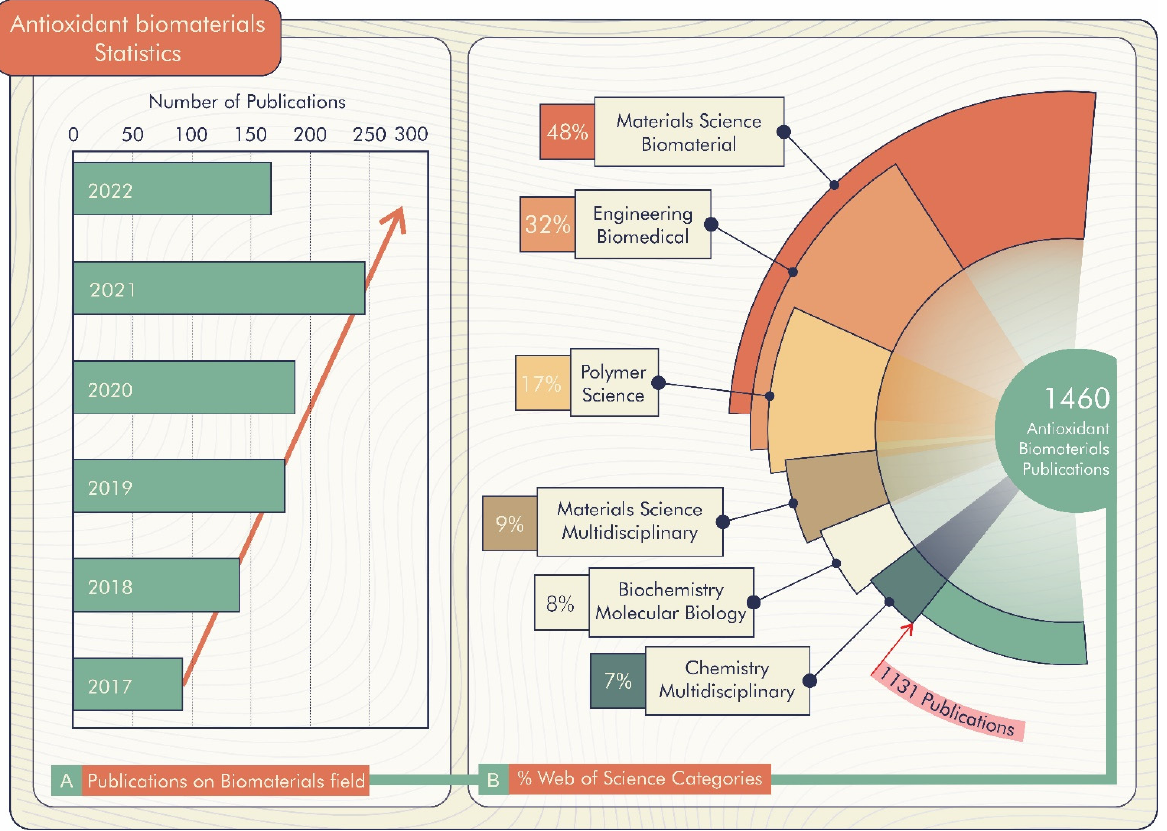
Figure 2. ( A ) Percentage of publications about biomaterials in research fields of Web of Science. ( B ) Publications on biomaterials field (18 April 2022).